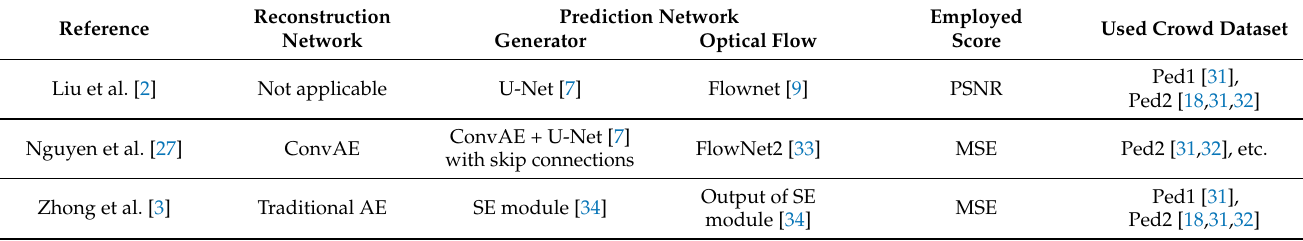
Table 1. A qualitative comparison of the most related works. MSE: Mean Square Error, PSNR: Peak Signal to Noise